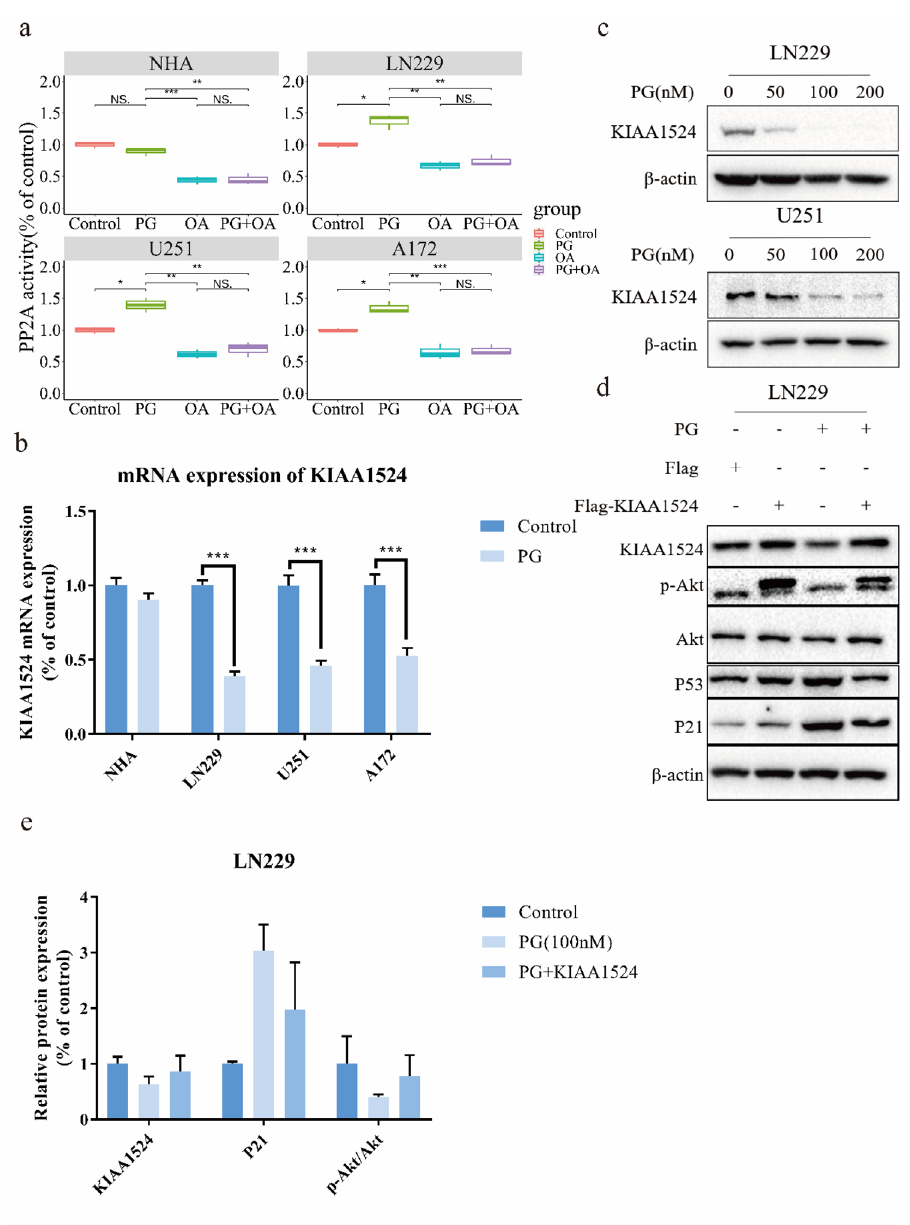
Figure 3. PG induced GBM cell cycle arrest by inhibiting the KIAA1524/PP2A signaling pathway ( a ) The activity of PP2A in GBM cells was increased after exposure to PG: GBM cells were treated with PG, OA or both at 100 nM for 24 h, and cell lysates were extracted to assess the activity of PP2A. ( b ) RT-PCR analysis of KIAA1524 expression in LN229, U251 and A172 cells treated with or without PG. ( c ) Western blotting analysis of KIAA1524 expression in LN229 and U251 cells treated with or without PG. ( d ) Western blotting analysis of the target proteins after ectopic expression of KIAA1524 in LN229 cells. Experiments were performed three times. ( e ) Graphic representation of relative levels of protein expression in LN229 cells treated with PG with or without KIAA1524. Data are expressed as the means ± SD. p <